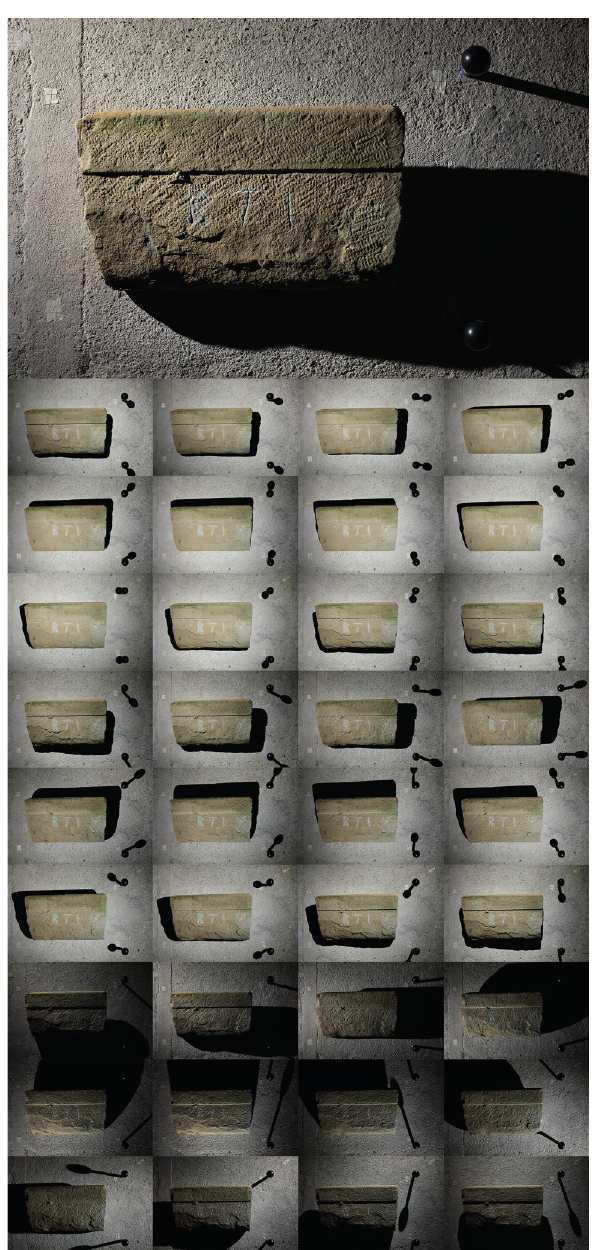
Figure 6a. RTI process: images with spot light only. Figure 6b. RTI process: images with spot light and diffuse